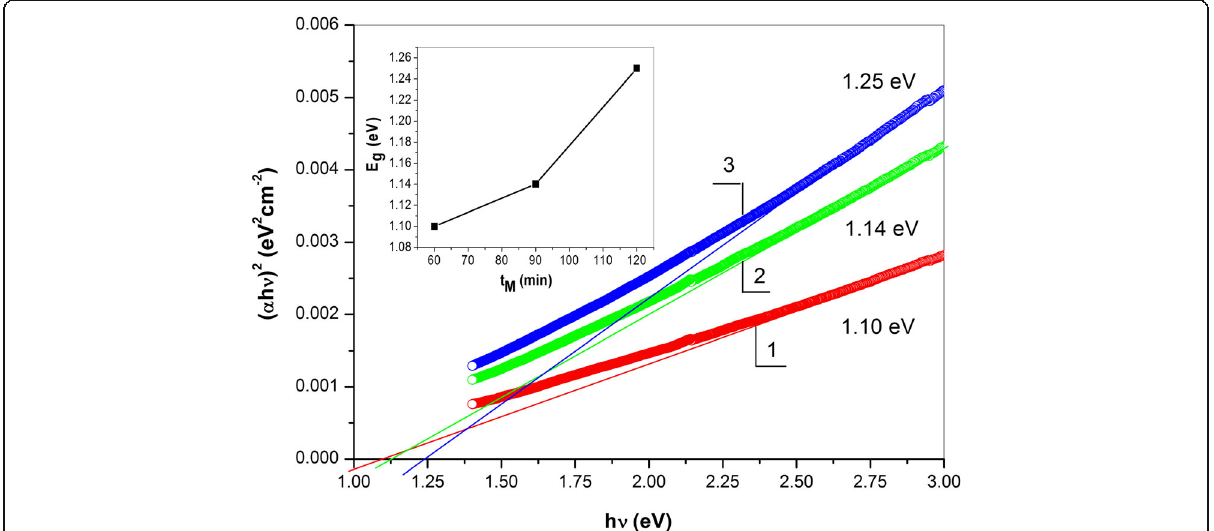
Fig. 3 Optical bandgap estimation for CFTS samples synthesized by milling at 60 (1), 90 (2), and 120 (3) min (the dependence on milling time is given in the inset )